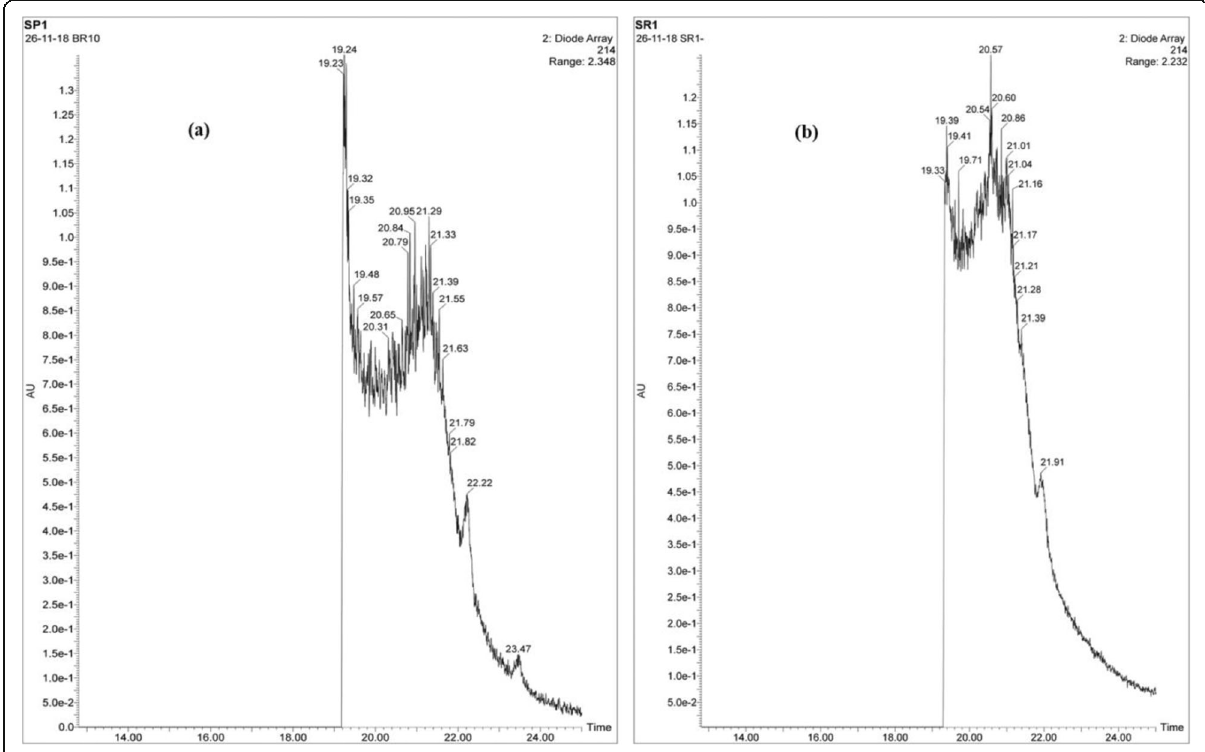
Fig. 4 RP-HPLC chromatogram of 3 kDa permeate of fermented soy milk produced by ( a ) M2 and ( b )